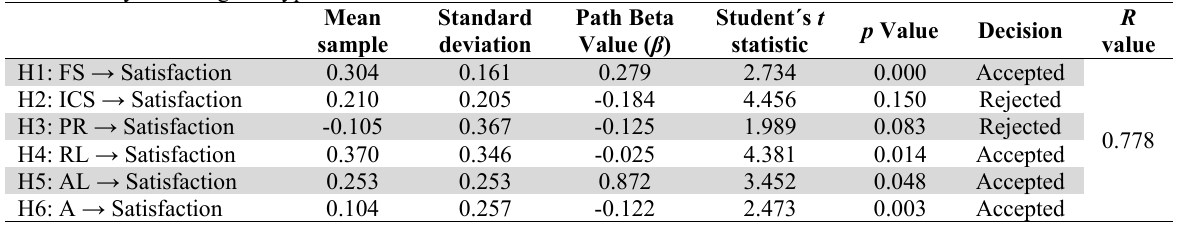
The summary of testing the